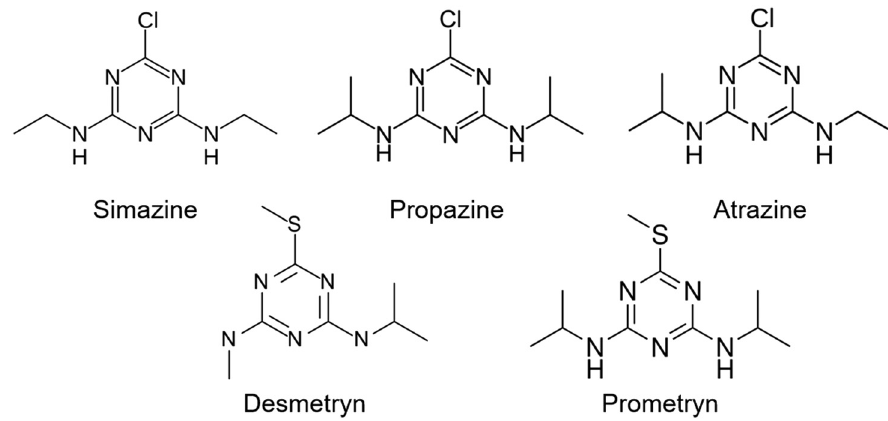
Figure 1: Structural formulas of studied heterocyclic triazine